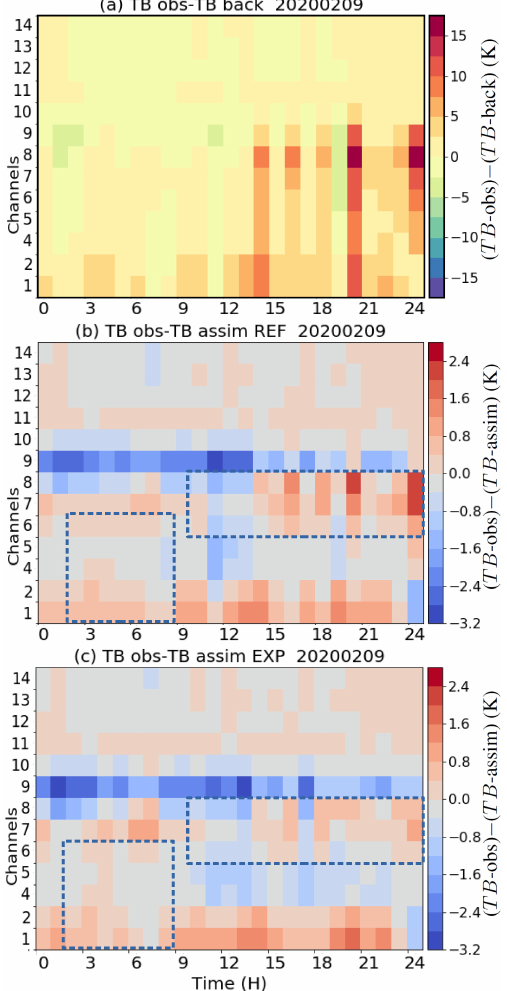
Figure 5. Differences in observed (channels 1, 2 and 4 to 7 located between 22 and 31GHz and channels 8 to 14 located between 51 and 58GHz, HATPRO radiometer) and simulated (with RTTOV-gb) TBs (in Kelvin): (a) from AROME background profiles, (b) from 1D-Var analyses from the REF configuration and (c) from 1D-Var analyses from the EXP configuration for all hours of the day on 9 February 2020 at Saint-Symphorien (Les Landes region). The dashed blue boxes indicate the channels and times where EXP is improved with respect to REF. Colour bars are in unit of